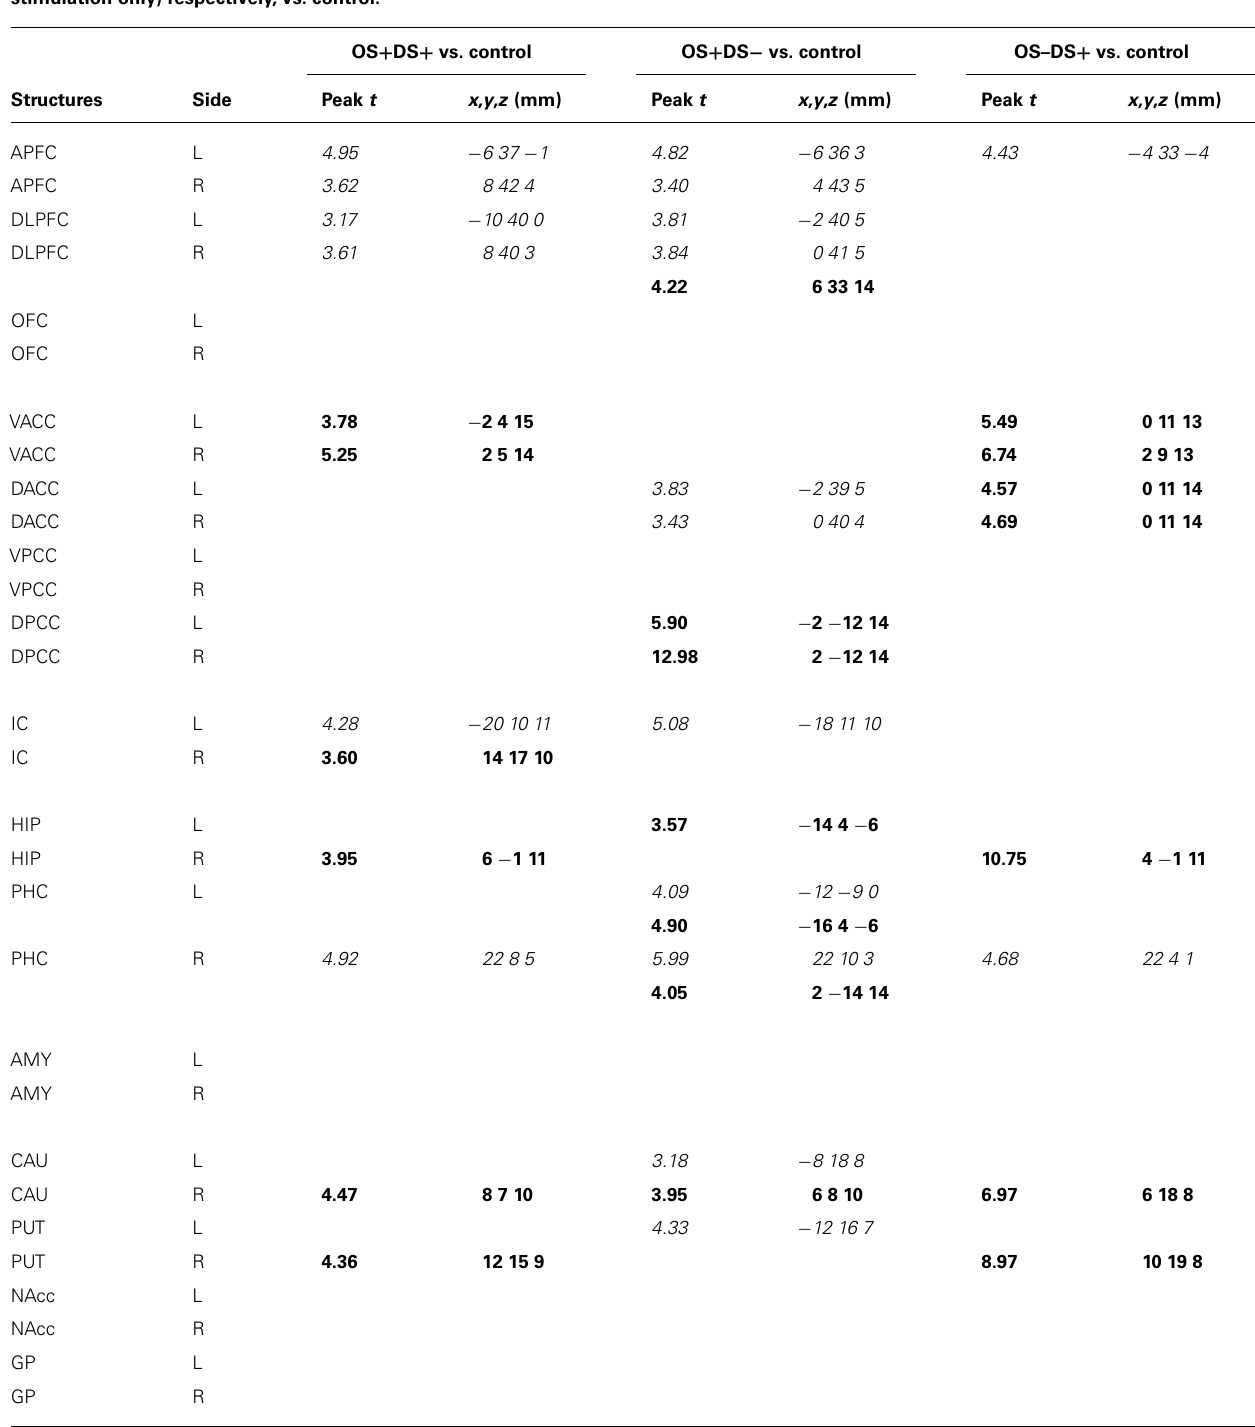
Table 1 | Summary of the brain activations (bold) and deactivations (italic) identified in the regions of interest selected for the small volume correction (SVC) analysis using the SPM (statistical parametric mapping) software ( t > 3.14; P < 0.01 uncorrected) and for the following contrasts: OS + DS + (oral and duodenal sucrose stimulation), OS + DS − (oral sucrose stimulation only), and OS − DS + (duodenal sucrose stimulation only) respectively, vs. control. OS + DS + vs. control OS + DS − vs. control OS–DS + vs. control